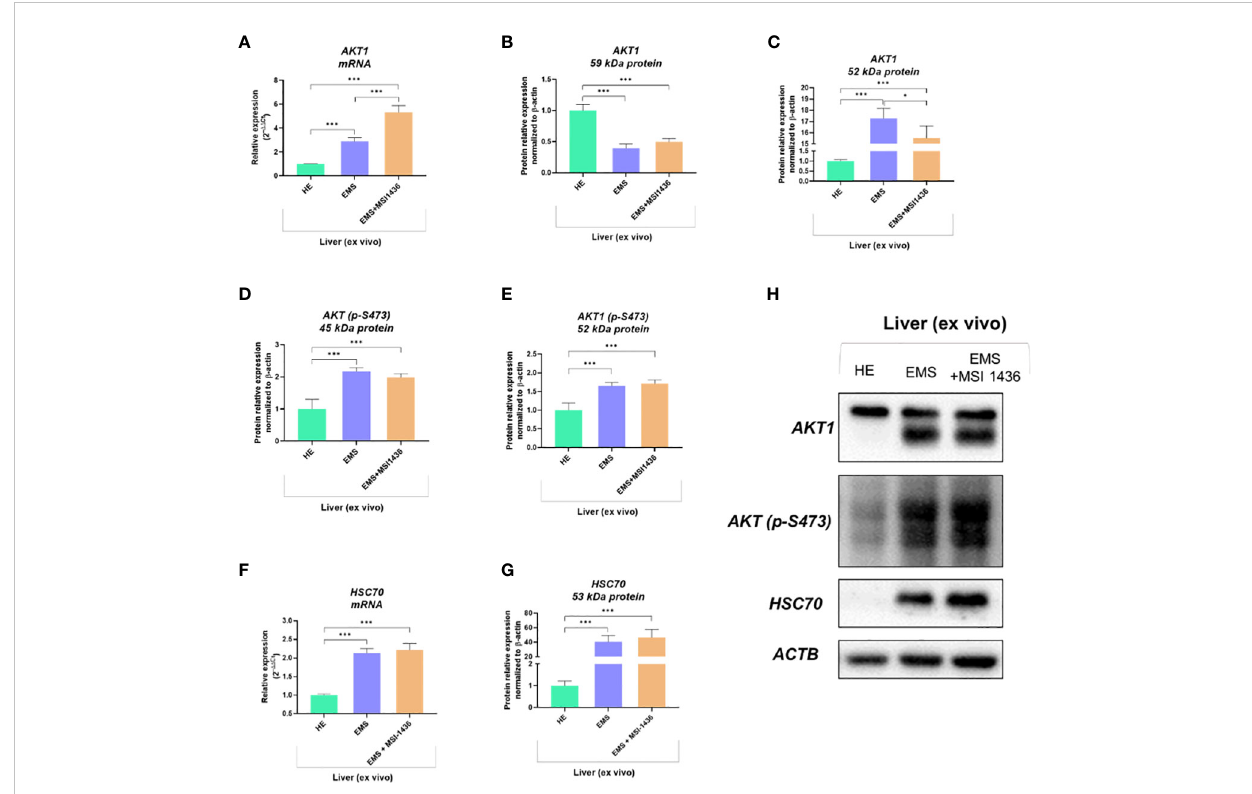
FIGURE 5 The expression of AKT1 and HSC70 governed by MSI-1436. The analysis included the determination of total AKT1 mRNA levels (A) , protein expression and phosphorylation (B-E, H) as well as evaluation of HSC70 transcript (F) and protein accumulation (G, H) . Data are presented as a mean value obtained from measurments ± SD. Statistical signi fi cance was marked as follows: *p-value < 0.05 and ***p-value <